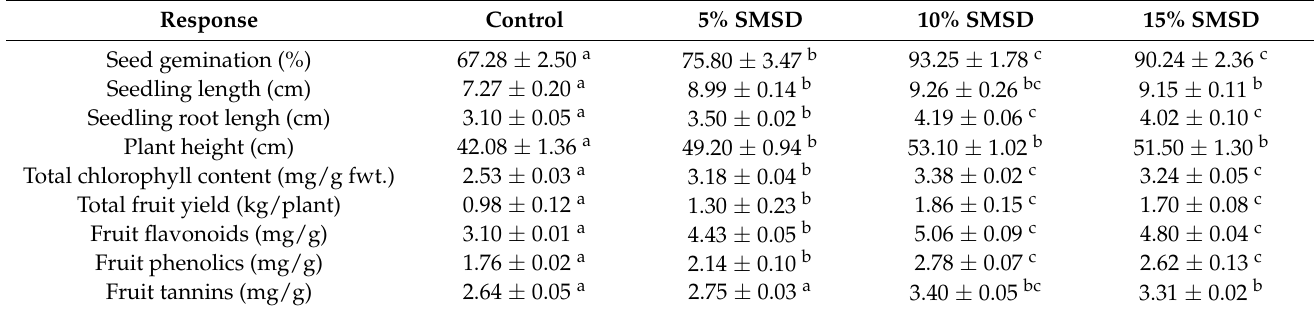
Table 4. Effect of spent mushroom substrate digestate (SMSD) mixing on germination, growth, biochemical, and yield response of